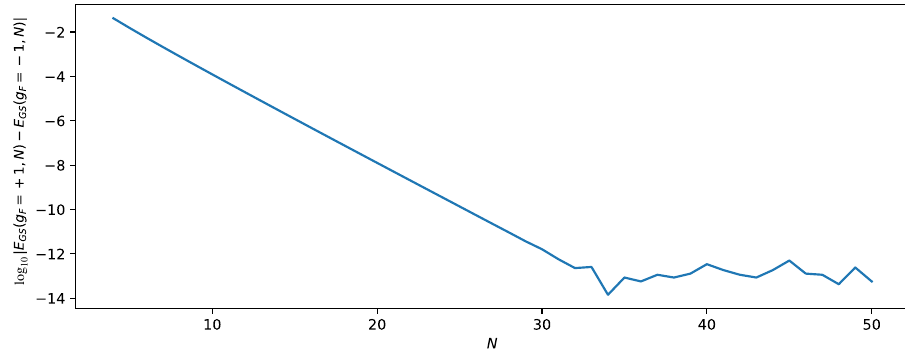
= ± 1 converge exponen- F